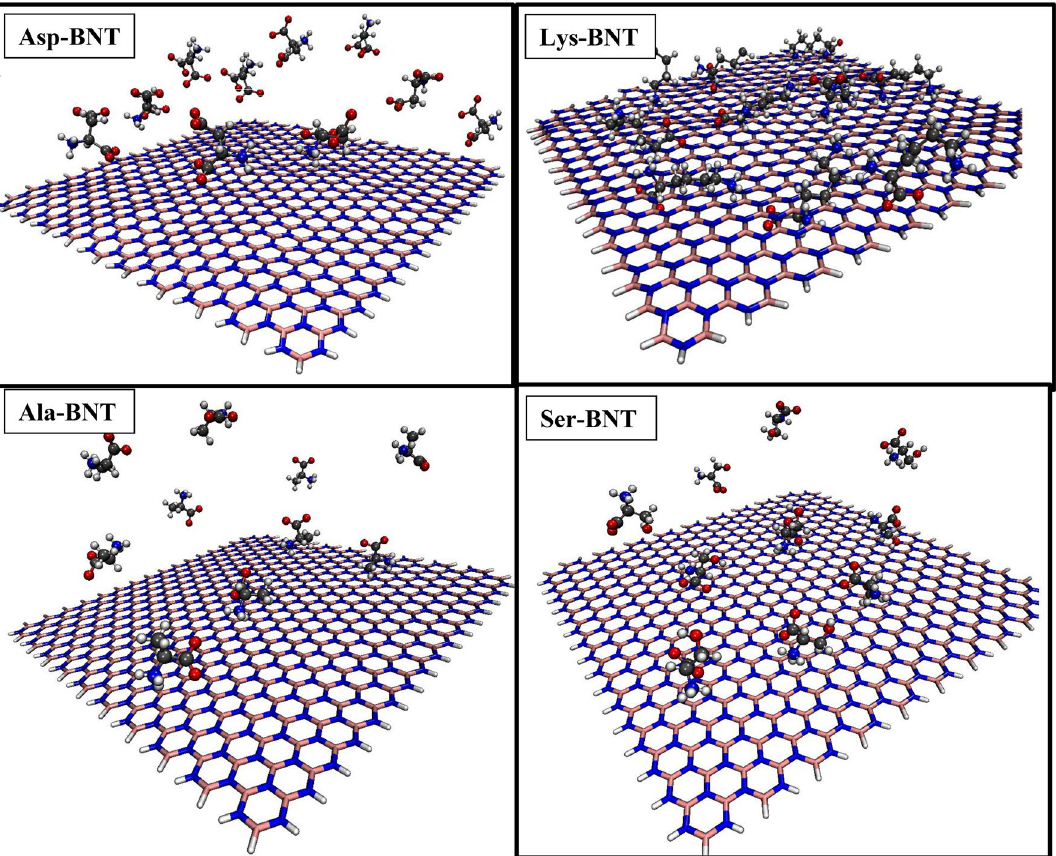
Figure 2. Final snapshots of investigated systems obtained from MD simulations [atomic symbols: N (blue), O (red), C (gray), B (pink), and H (white)].